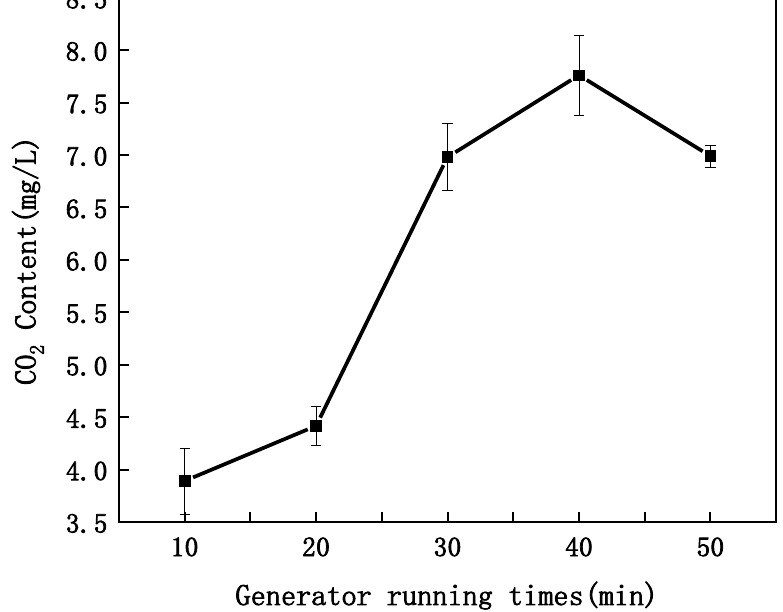
Figure 3. Line graph of the CO 2 content changes at different running times. (3) Impact of Inlet Water Temperature on CO 2 MNB content The solubility of gas has an impact on the gas–liquid equilibrium balance inside the reaction vessel. Furthermore, temperature is an important factor influencing gas solubility [26,27]. As a result, an investigation of the effect of the inlet water temperature was required. Figure 4 depicts the effect of the inlet water temperature on the CO 2 content of the MNB water. The amount of CO 2 dissolved in the water gradually decreased as the incoming water temperature increased, as seen in the